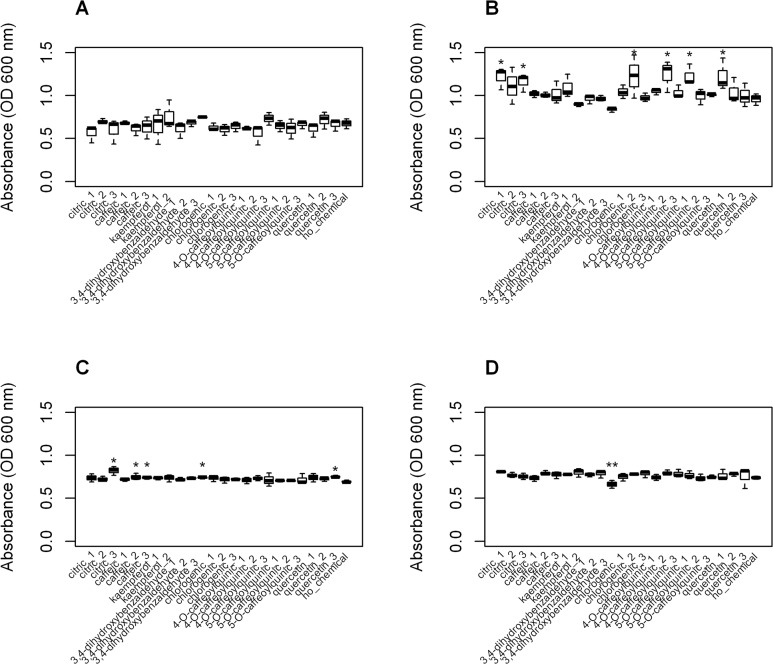
Growth of methicillin-sensitive (SA) and methicillin-resistant Staphylococcus aureus MRSA) in the presence of pure compounds.At concentrations of 10 μg/ml (chemical_1), 20 μg/ml (chemical_2) and 100 μg/ml (chemical_3), growth with compounds was compared to the positive growth control (no chemical added) to determine inhibitory activity. Statistically significant differences greater (*) or less (**) than control are marked by asterisks. Growth of A. SA 113, B. SA 27708, C. MRSA 35591, and D. MRSA 35593 are reported at 48 h. SA113 had a significant block by treatment interaction, so no conclusions can be drawn from it.